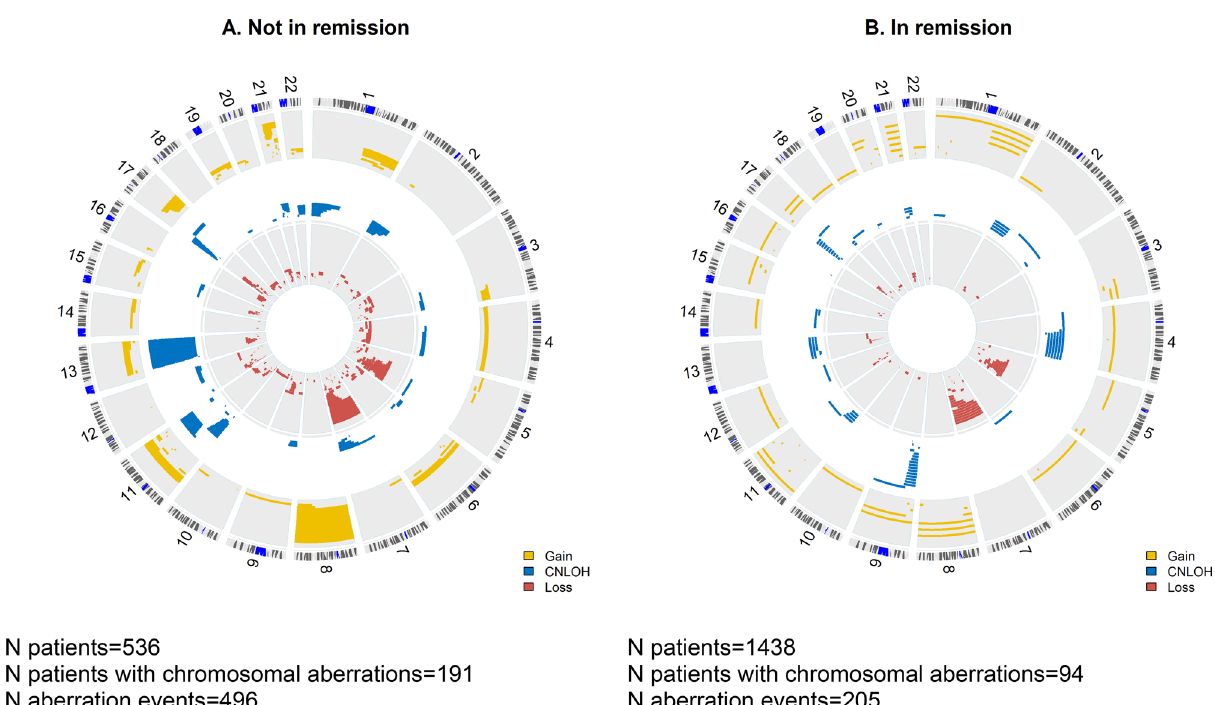
Figure 1. Genomic location and type of chromosomal aberrations among patients with AML. ( A ) Advanced disease (not in remission), ( B ) in complete remission; Yellow: copy-gain, blue: copy-neutral loss of heterozygosity (CNLOH), red: copy-loss. R package “OmicCircos” version 1.28.0 31 was used to create the